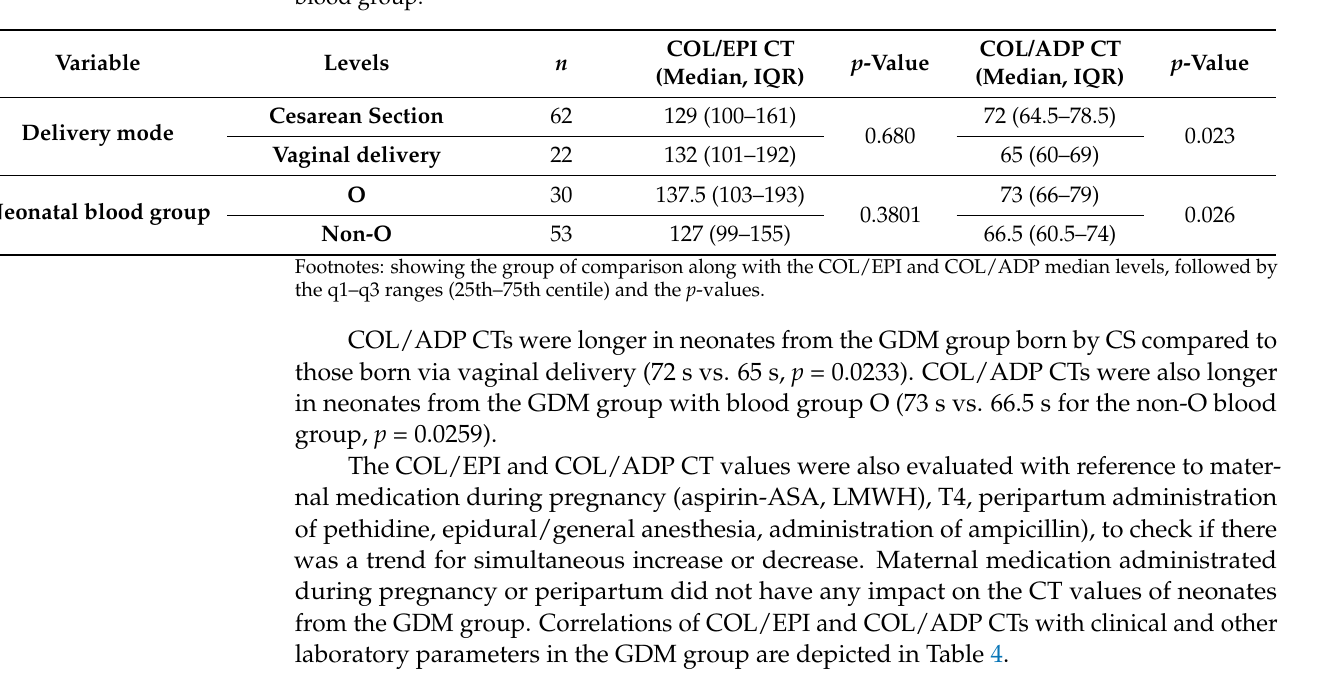
Table 3. The comparison of CT values in the GDM group, with respect to delivery mode and neonatal blood group.